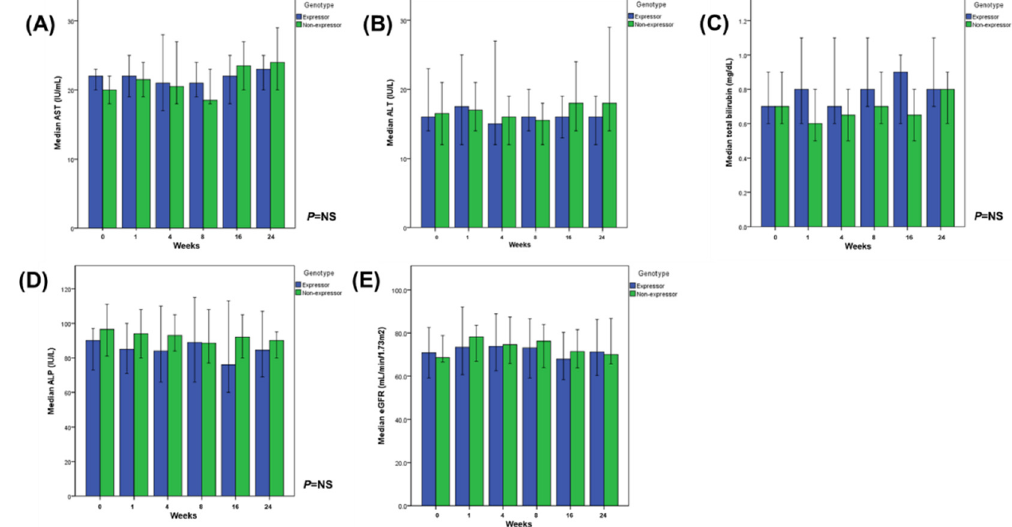
Figure 2. Laboratory parameters of CYP3A5 expressors and non-expressors determined during regular control visits in per-protocol set (medians with 95% confidence interval). ( A ) Aspartate aminotransferase (AST), ( B ) Alanine aminotransferase (ALT), ( C ) total bilirubin, ( D ) Alkaline phosphatase (ALP), and (E) eGFR.